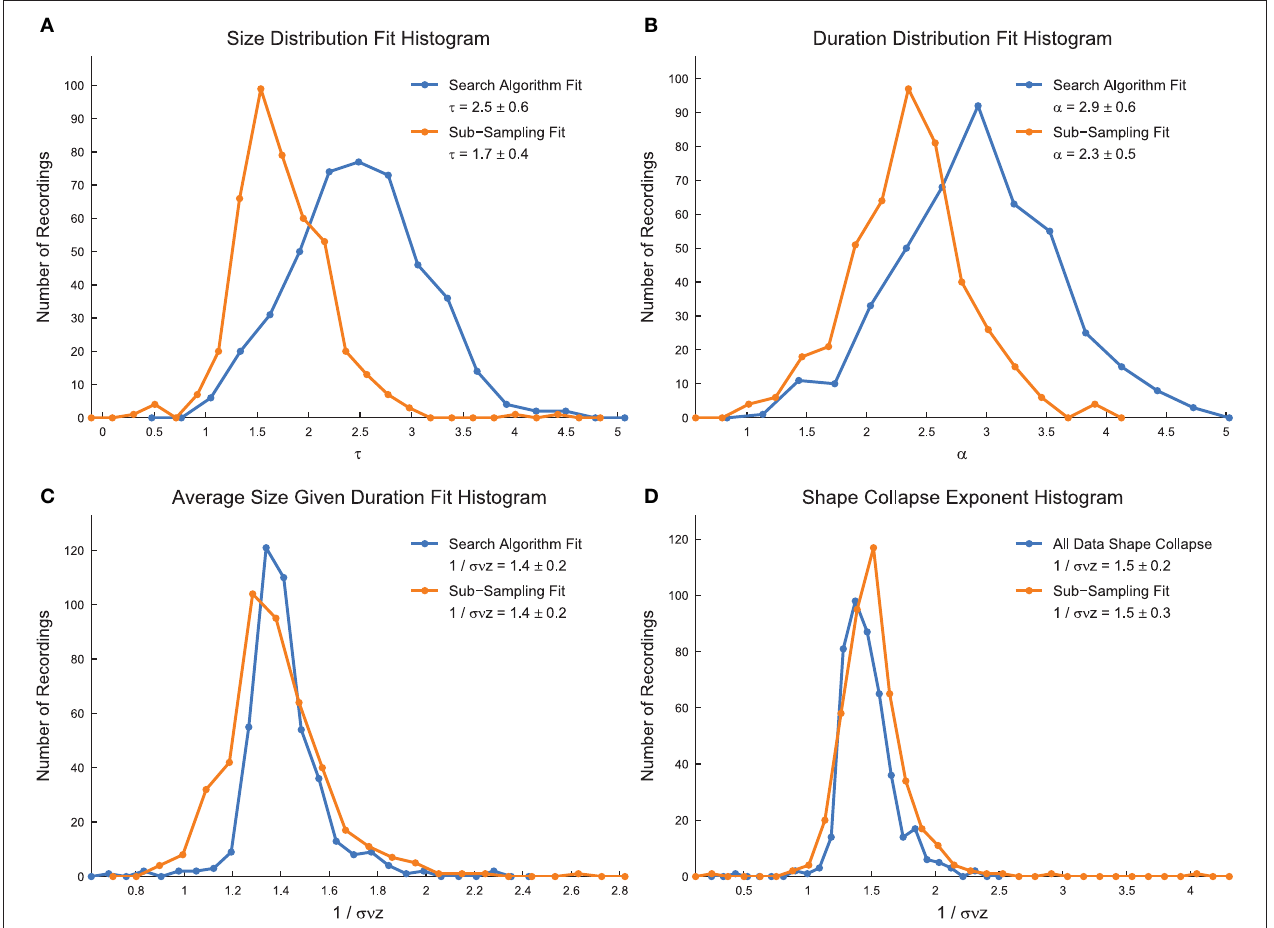
FIGURE 8 | Power-law exponents in culture data. (A) Size distribution critical exponent ( τ ) values for all culture recordings analyzed. (B) Duration distribution critical exponent ( α ) values for all culture recordings analyzed. (C) Average size given duration data critical exponent (1 /σν z ) values for all culture recordings analyzed. (D) Shape collapse critical exponent (1 /σν z ) values for all culture recordings analyzed. In all subfigures, the quoted critical exponent value is mean ± standard deviation. Also, histogram bin sizes optimized using methods established in Terrell and Scott (1985).